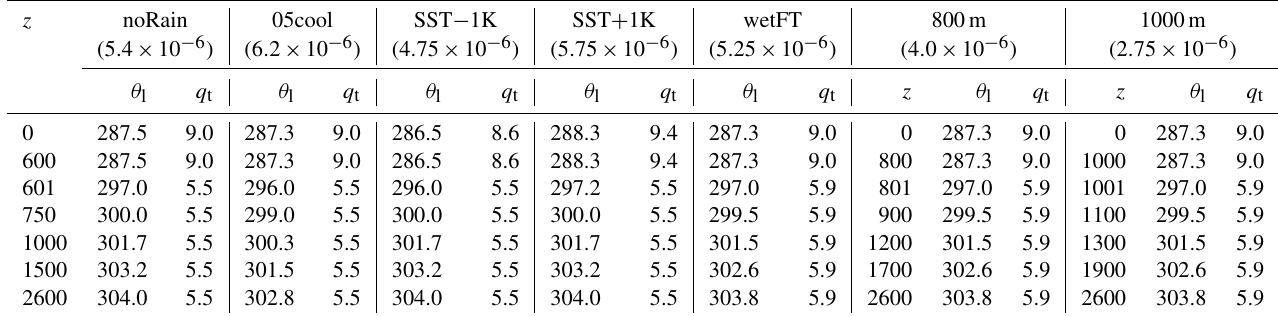
Table 4. Initial profiles of liquid water potential temperature ( θ l ; K) and total liquid mass mixing ratio ( q t ; gkg − 1 ) against altitude ( z in metres) for each cloud sensitivity setup. Values in parentheses indicate the large-scale divergence rate ( D ; s − 1 ) used for each setup. All setups result in a stable stratocumulus cloud deck at the top of the boundary layer.